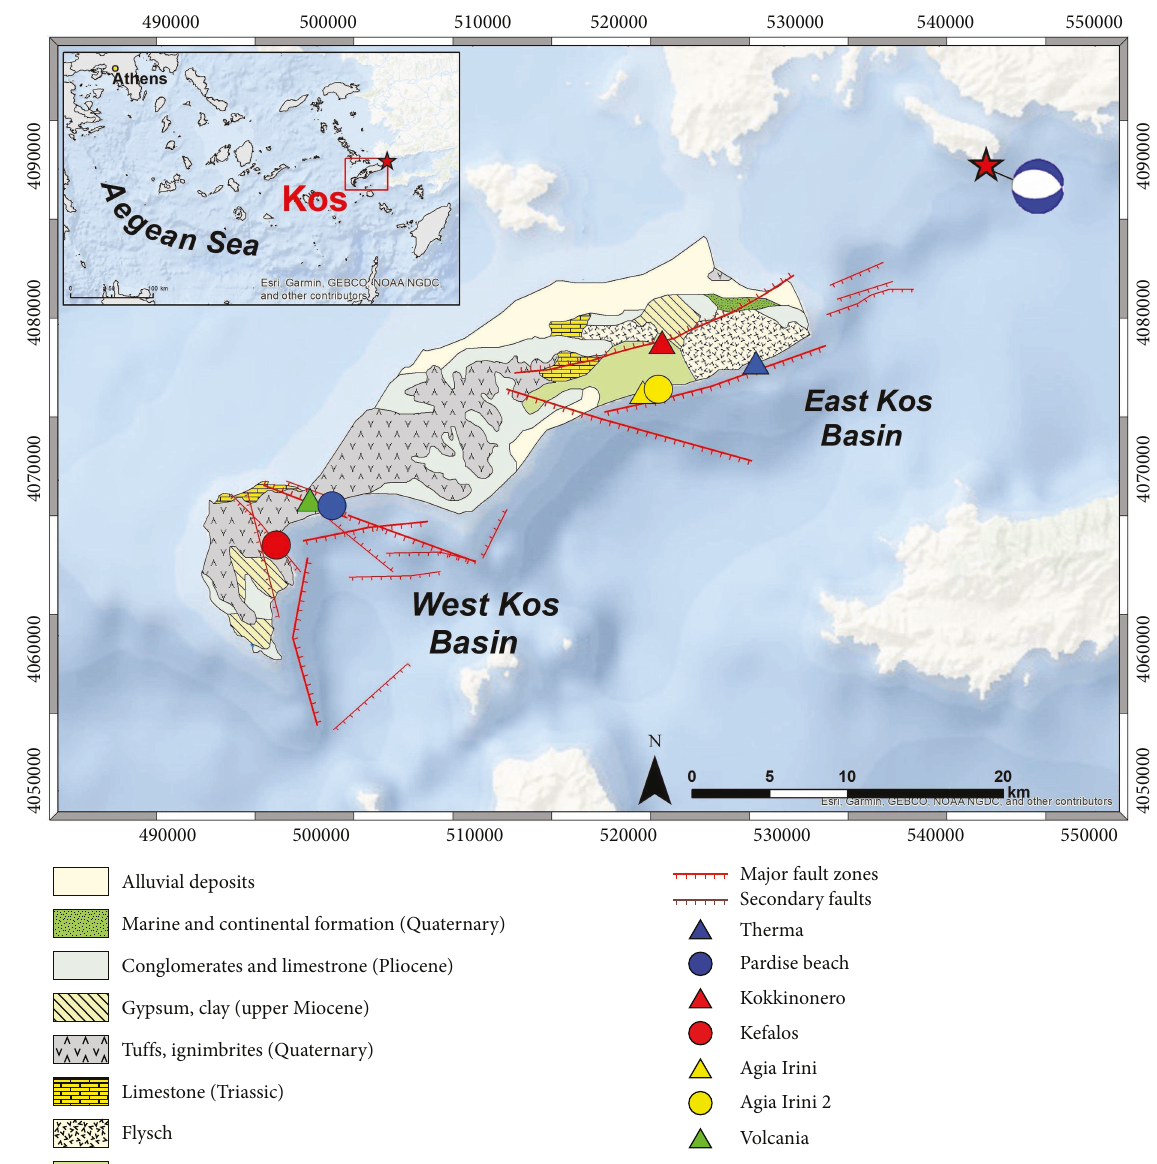
Figure 1: Simpli fi ed geological map of the island of Kos (modi fi ed after [14, 37]) with the geographical position of the gas sampling points. The earthquake epicenter ( M w = 6 6 ) on the 20 th of July 2017 is indicated by a red star. Hypocentral depth (11 km) and focal mechanism are taken from